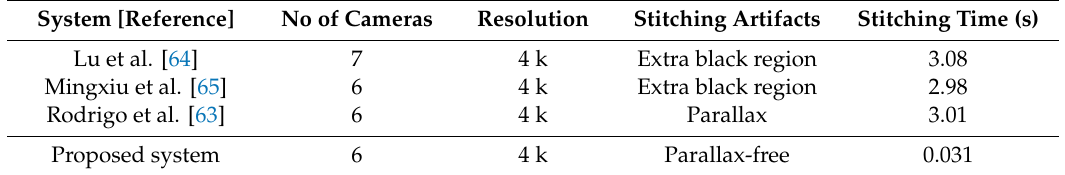
Figure 8. Quantitative performance evaluation of our proposed system compared to existing manual panorama generation software programs. Table 4. Comparison of the proposed system with state-of-the-art mono panorama generation systems.